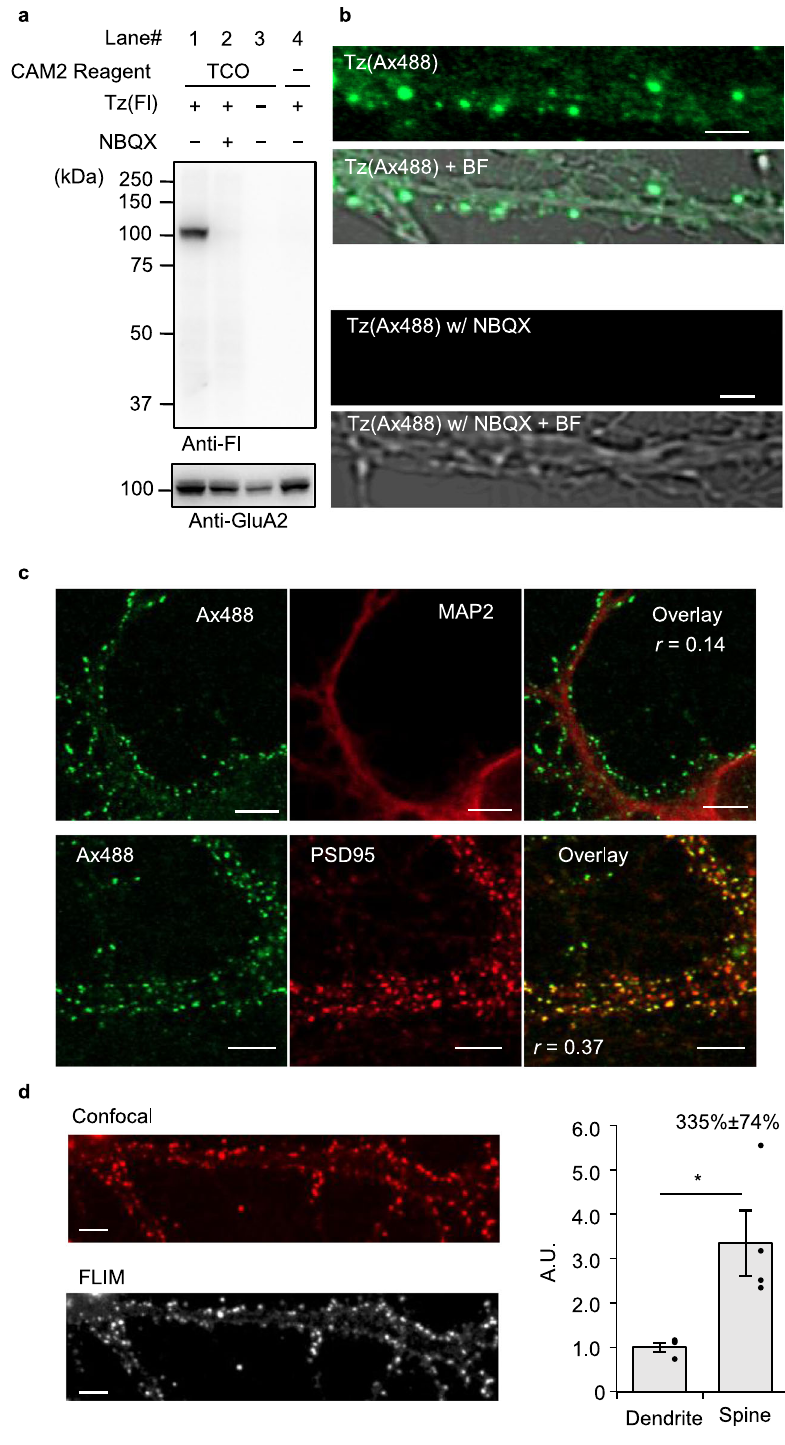
Fig. 4 The two-step labeling of cell-surface AMPARs endogenously expressed in neurons. a Western blotting analyses of cortical neurons after the two- step labeling. Primary cultured cortical neurons were treated with 2 μ M CAM2(TCO) for 10 h followed by the addition of 1 μ M Tz(Fl) for 5 min in the presence or absence of 50 μ M NBQX in culture medium at 37 °C. The cell lysates were analyzed by western blotting using anti- fl uorescein or anti-GluA2 antibody. b Confocal live imaging of the neurons labeled with 2 μ M CAM2(TCO) and 0.1 μ M Tz(Ax488). Labeling was conducted as described in a . Scale bars, 2 μ m. c Immunostaining of cortical neurons after the two-step labeling. Labeling was conducted as described in b . The neurons were fi xed, permeabilized, and immunostained using anti-MAP2 (upper) or anti-PSD95 antibody (lower). Scale bars, 5 μ m. Pearson ’ s correlation coef fi cients ( r ) are shown in the image. Whole images are shown in Supplementary Fig. 14a. d FLIM imaging and analyses of cell-surface AMPARs in the neurons after the two-step labeling. The neurons were prepared as described in c . In left, representative confocal image (upper) and FLIM image (lower) for a lifetime fraction ( τ = 2.4 ± 0.1 ns) are shown. Scale bars, 5 μ m. In right, FLIM intensities in spine and dendrite were analyzed ( n = 4 cells). [CAM2(TCO)] = 2 μ M, [Tz(Ax488)] = 0.1 μ M. *Signi fi cant difference ( p < 0.05 by two-sided Student ’ s t -test. p = 0.048). Data are represented as mean ± s.e.m. NATURE COMMUNICATIONS| (2021) 12:831 |https://doi.org/10.1038/s41467-021-21082-x|www.nature.com/naturecommunications